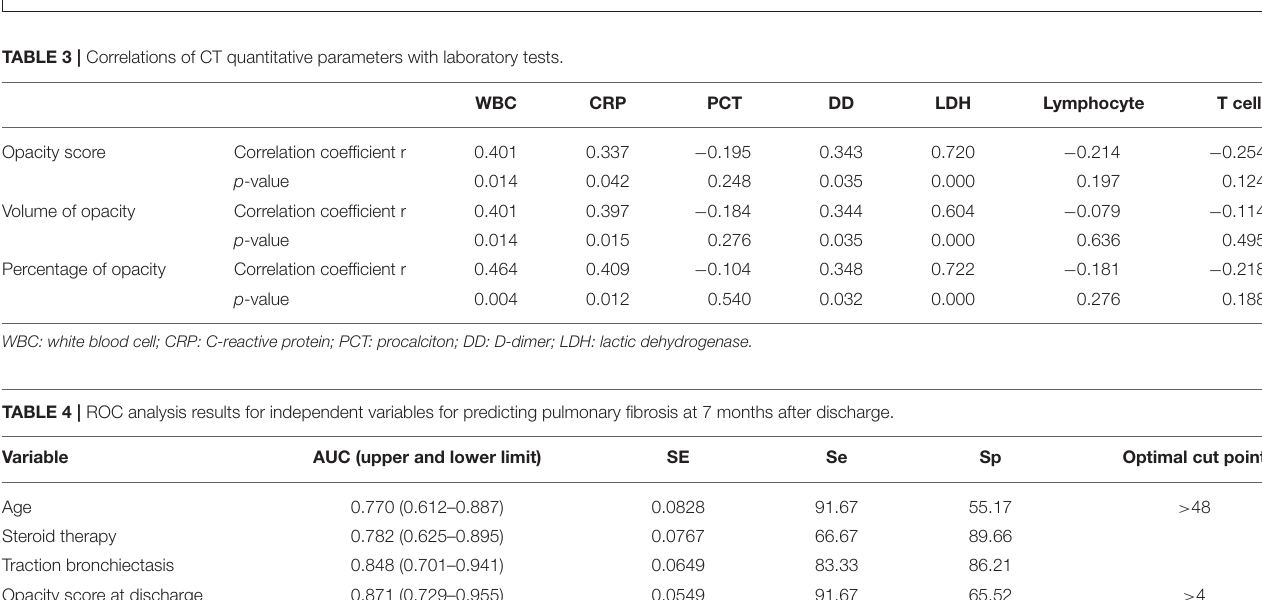
FIGURE 3 | Follow-up chest CT images of a 48-year-old female with COVID-19. (A) At discharge, CT imaging shows crazy paving pattern, parenchymal bands, irregular interfaces, and reticular pattern in bilateral lungs. (B) 3-month follow-up CT shows parenchymal bands, irregular interface, and traction bronchiectasis in the right lower lobe, which indicates fibrosis. (C) The lesions on 7-month follow-up CT are still present. This patient was enrolled in fibrosis group.